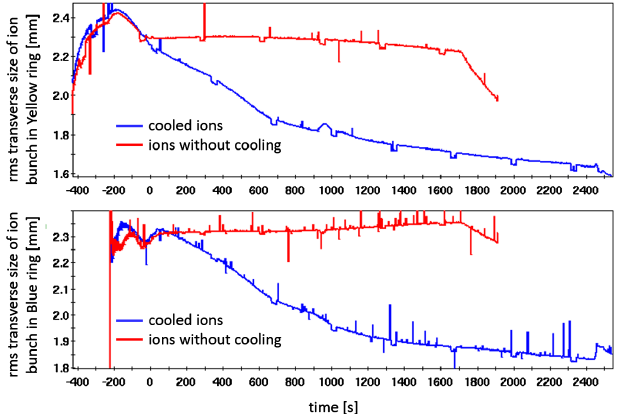
FIG. 7. Transverse beam size of ion bunches in the yellow (top) and the blue (bottom) RHIC rings for cooled (blue line) and not cooled (red line) stores. The spikes and the periodic (5 min) abrupt steps in the signal are artifacts of the measurement system.